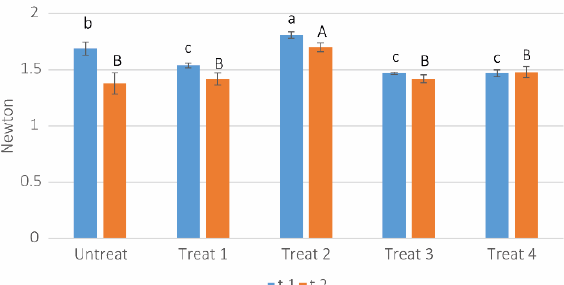
Figure 6. Leaf hardness in each treatment at two times (t1 and t2). Different letters indicate significant differences ( p < 0.05). Lowercase letter are used for t1 results and capital letter are used for t2 results.